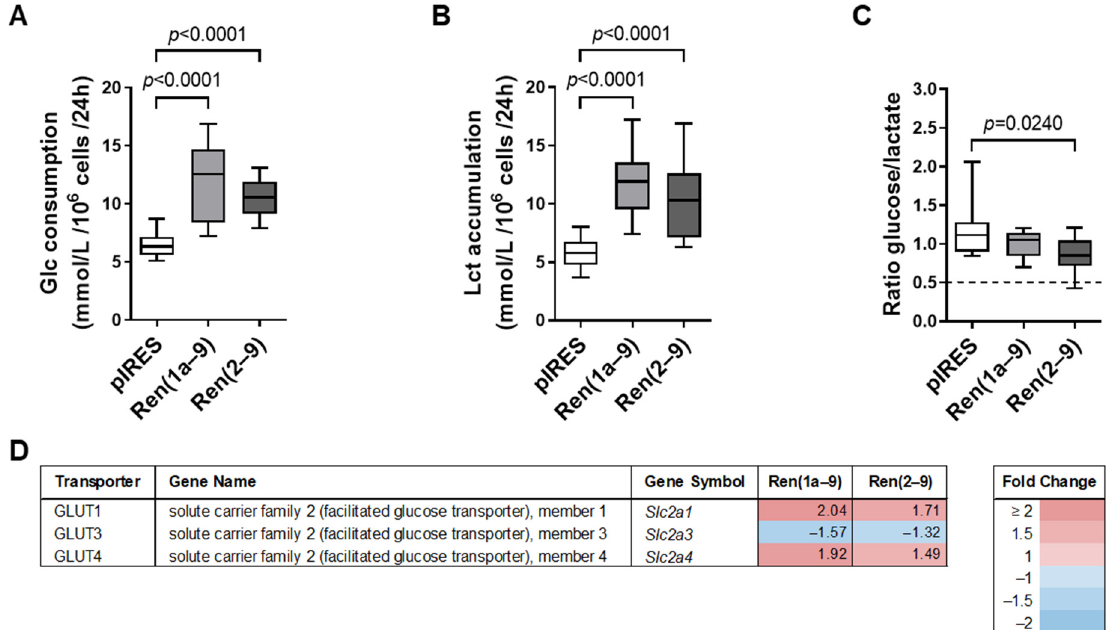
Figure 4. Metabolic alterations induced by renin-b overexpression. ( A ) Increased glucose (Glc) consumption, ( B ) increased extracellular lactate (Lct) accumulation, and ( C ) decreased ratio of glucose consumption to lactate accumulation as a result of either Ren(1a–9) or Ren(2–9) overexpression as compared with pIRES H9c2 control cells. The dashed line indicates the Glc/Lct ratio at anaerobic glycolysis when glucose is completely converted to lactate. ( D ) Expression of significantly altered class I glucose transporter-coding genes as identified by transcriptome analyses ( q < 0.05). The red color indicates genes with increased mRNA levels and the blue color indicates those with decreased mRNA levels as compared with pIRES controls. ( A – C ) Data of 9–18 independent experiments per group are shown as box plots, where the top of the box represents the 75th percentile, the bottom of the box represents the 25th percentile, and the line in the middle represents the median. The whiskers represent the highest and lowest values in the dataset. Data were analyzed by one-way ANOVA followed by Tukey’s test. Single p –values < 0.05 vs. pIRES controls are given in the